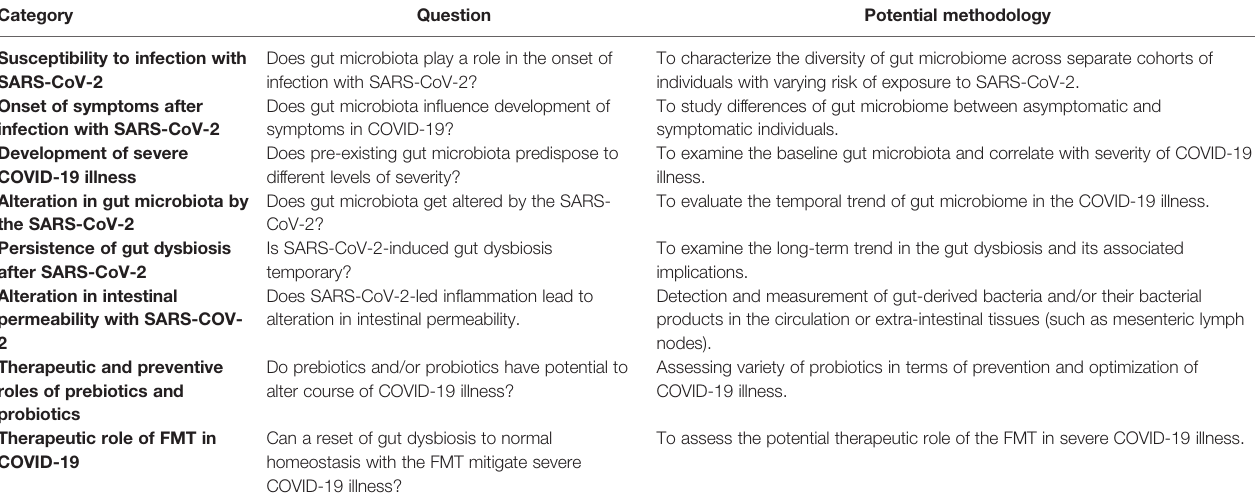
TABLE 2 | Unanswered questions and potential research methodology.